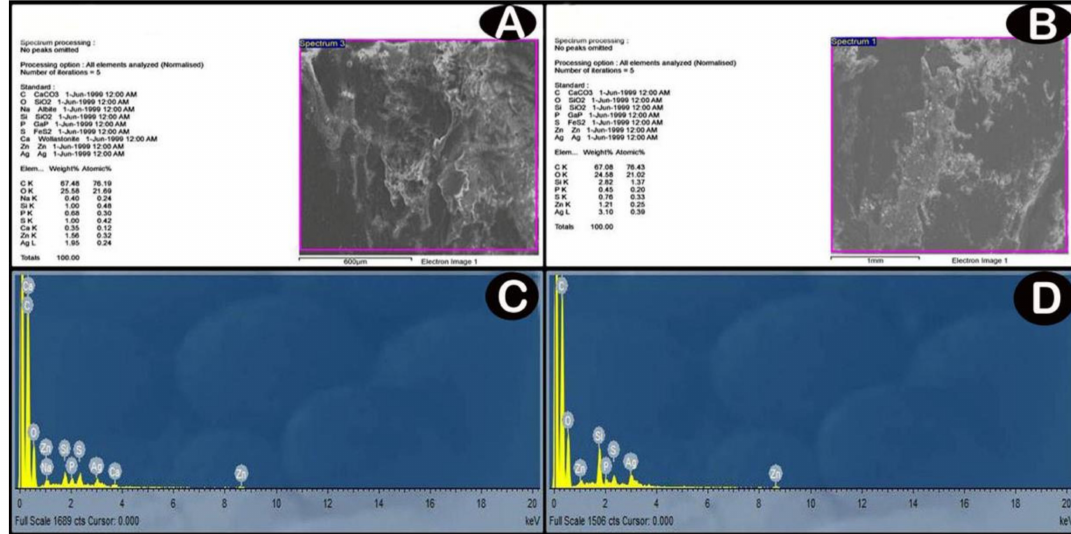
Figure 3. ( A , B ) SEM images; backscattered electron images show contrast due to different element compositions for low-dose and high dose groups, respectively. ( C , D ) analyses of EDX for detection of these elements and their relative amounts (atomic % and weight %) by the production of an X-ray spectrum from the whole scan area of the SEM. The Y -axis represents the sums of X-rays and the X -axis depicts their energy level (KeV). The elements are identified by the place of the peaks, while the height of the peaks is used to measure the quantity of each element. ( C ) low-dose group EDX spectrum shows a significant amount of Ag (one prominent peak at 3 KeV). ( D ) high-dose group EDX spectrum shows increased the amount of Ag compared with low-dose group (one prominent peak at 3